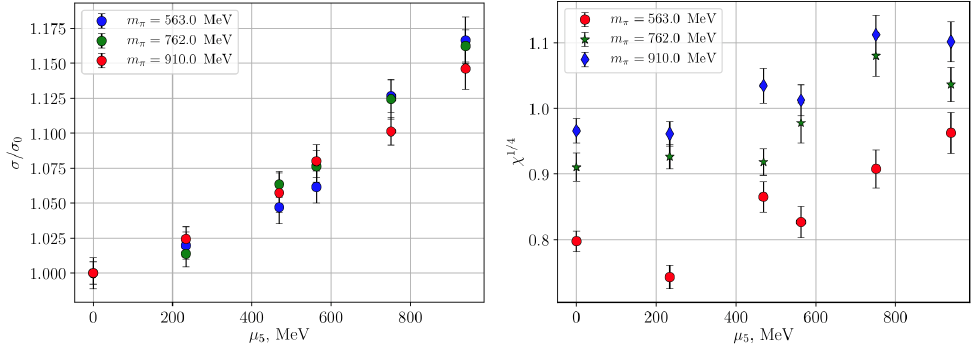
Figure 11. String tension ( left ) and topological susceptibility ( right ) in QCD as a function of the chiral chemical potential, and different pion masses. From Ref.